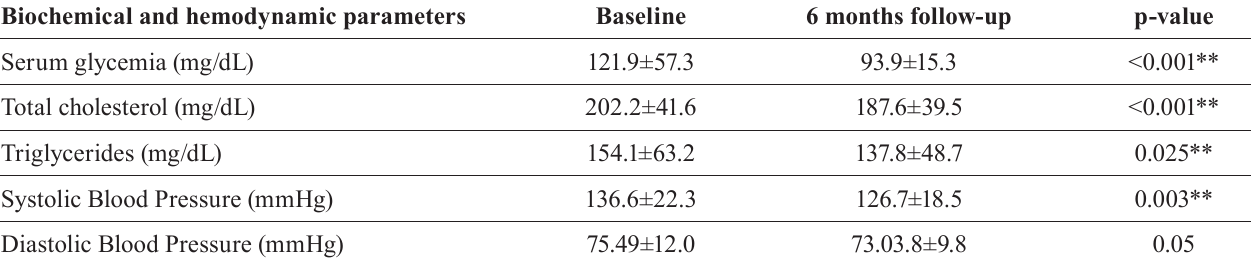
TABLE VI - Assessment biochemical and hemodynamic parameters of patients (n=55) in Alzheimer’s disease treatment, mean cognitive screening tests Mini Mental State Examination (MMSE) and staging of disease Clinical Dementia Rating (CDR), performed by the Medication Therapy Management (before-after),